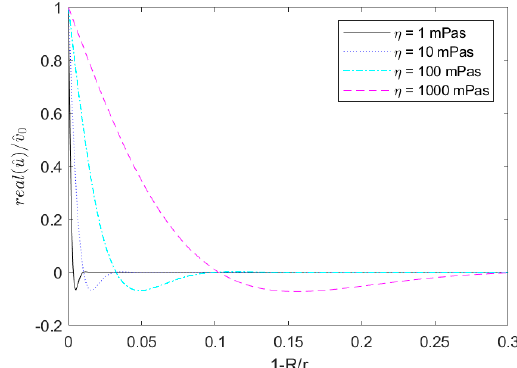
Figure 5. Velocity profile for different fluids in a tubular sensor with a frequency of 10,800 Hz and density of 1000 kg/m 3 .